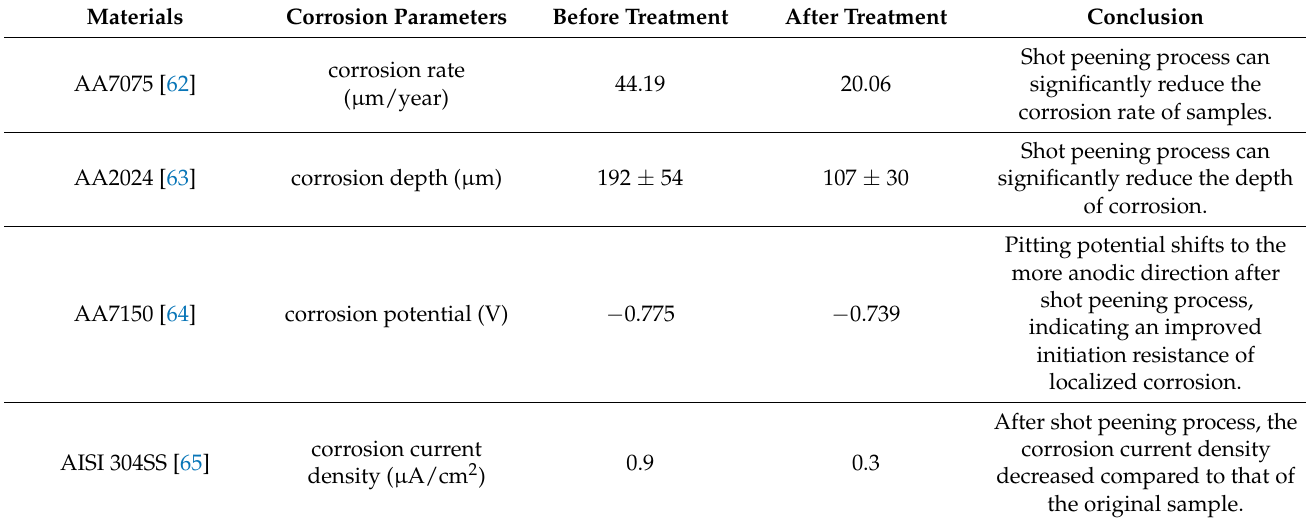
Figure 9. Corroded surface morphology of 319s aluminum alloy samples: ( a ) without shot peening; ( b ) with shot peening [61]. Table 3. Effect of shot peening process on corrosion resistance of aluminum